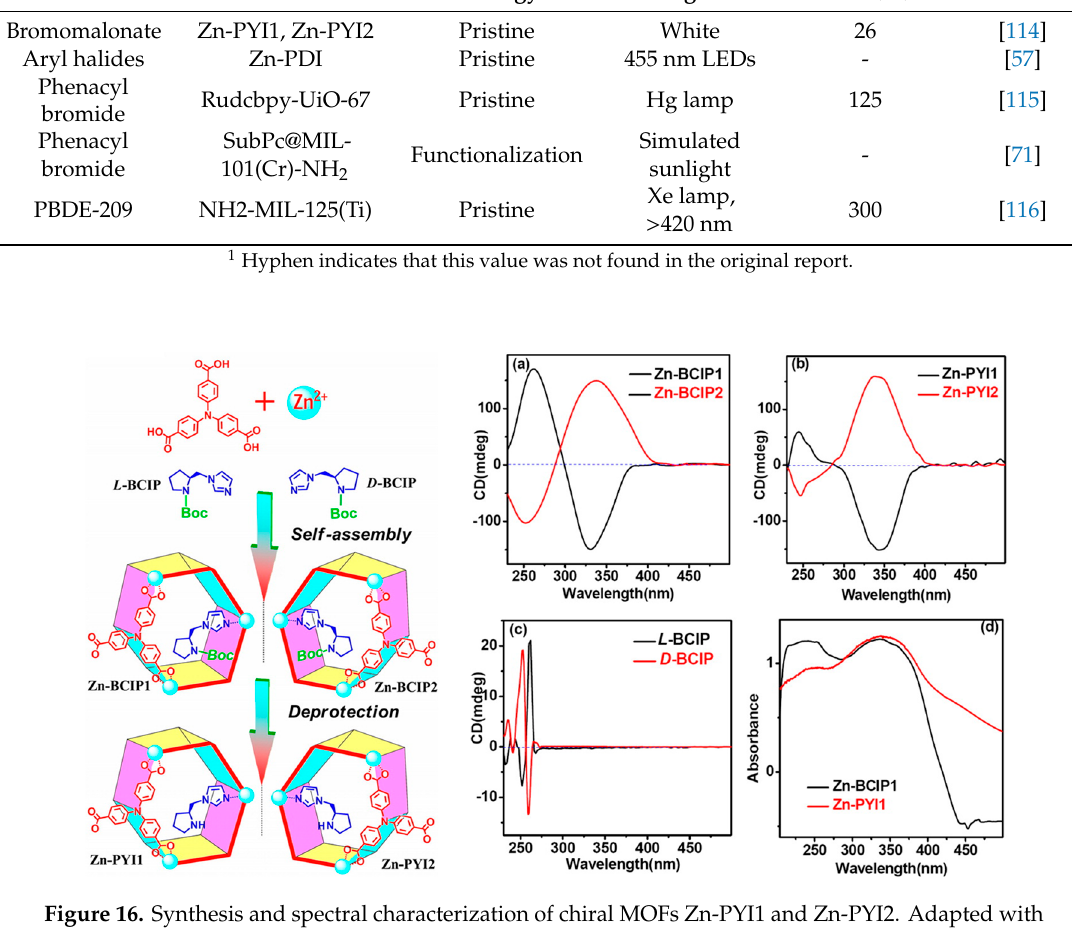
Table 14. Photocatalytic dehalogenation reactions mediated by MOFs.